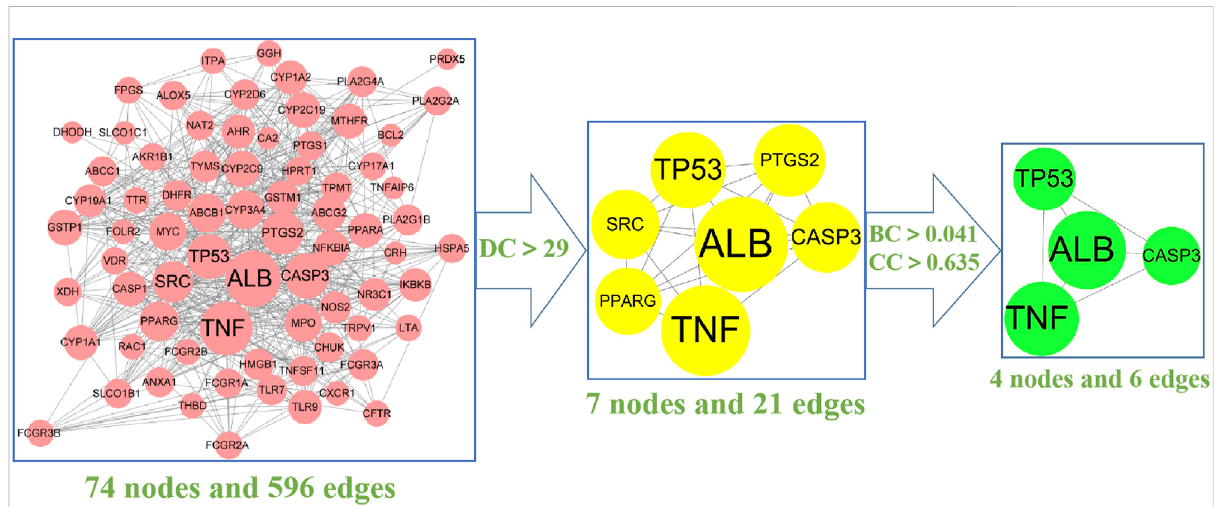
FIGURE 4 The screening process of the PPI network by Cytoscape: The 74 pink nodes represent the intersection targets of PPI network; The 7 yellow nodesrefertothetargetobtainedafterthe fi rstscreening(DC > 29);The4greennodesarethe fi nalcoretargetsobtainedafterthesecondscreening (BC > 0.041, CC > 0.635). (degree (DC), betweenness centrality (BC), closeness centrality (CC).The larger the circle is, the more critical the target